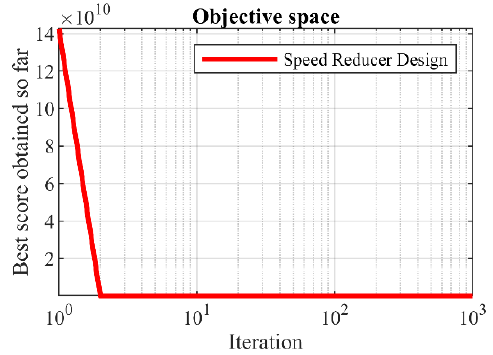
23 of 30 Table 12. Statistical results for speed reducer design problem. Algorithm